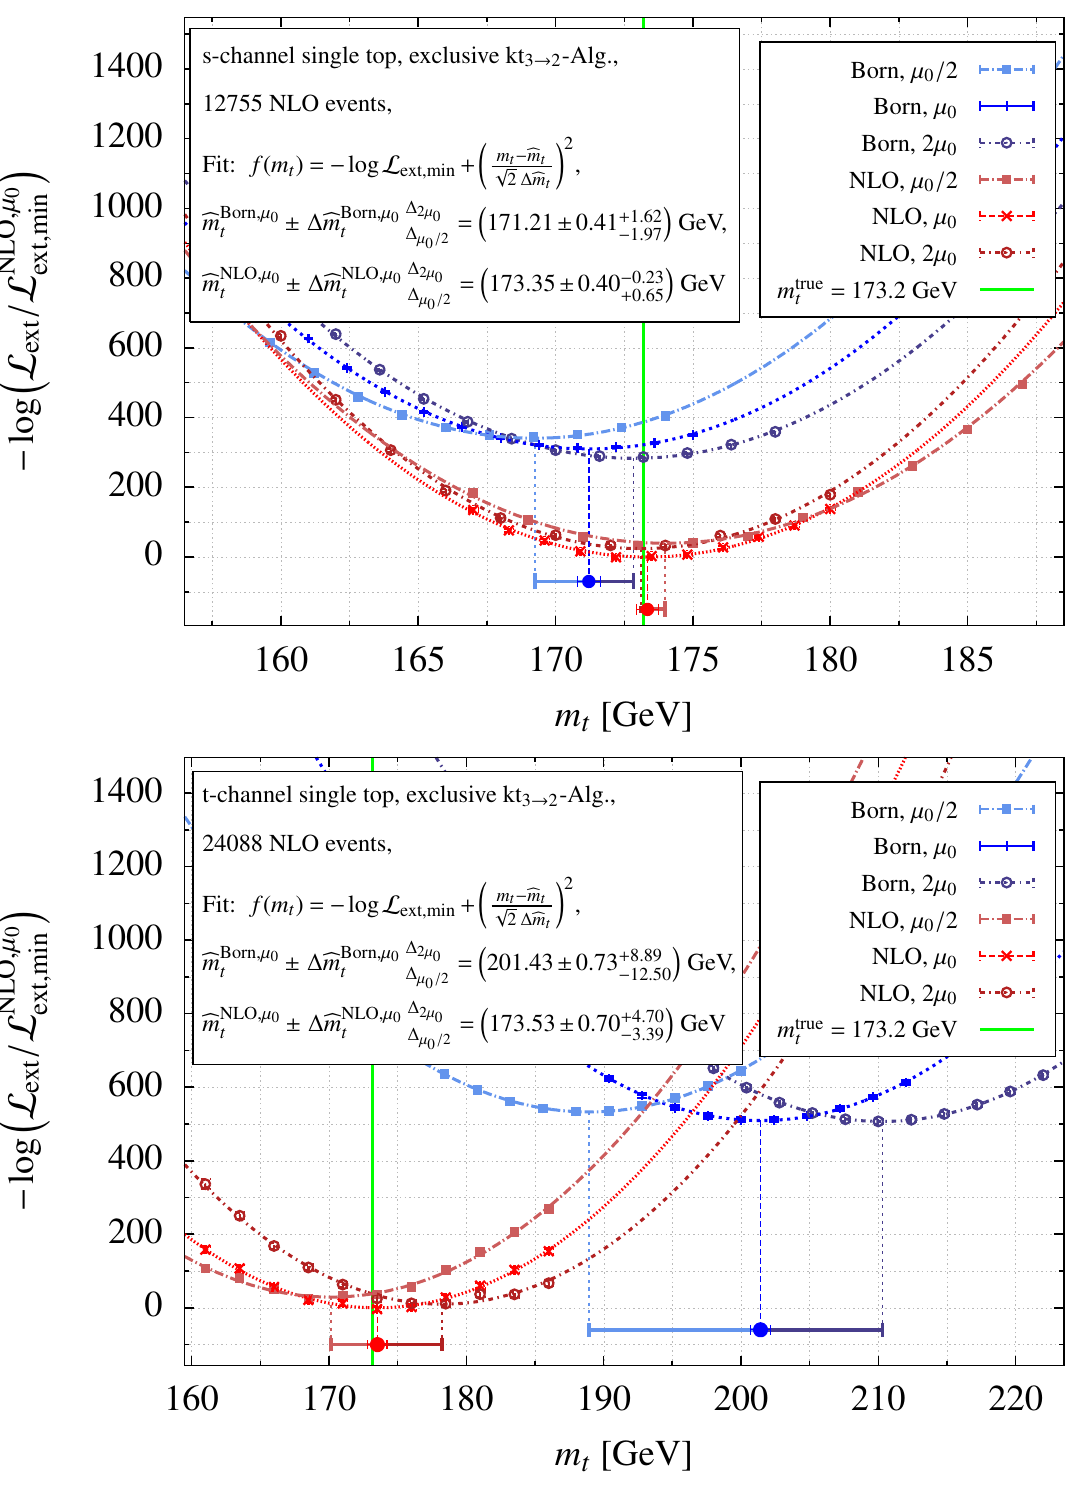
Figure 16 . Same as (cid:12)gure 14 but using the extended likelihood.